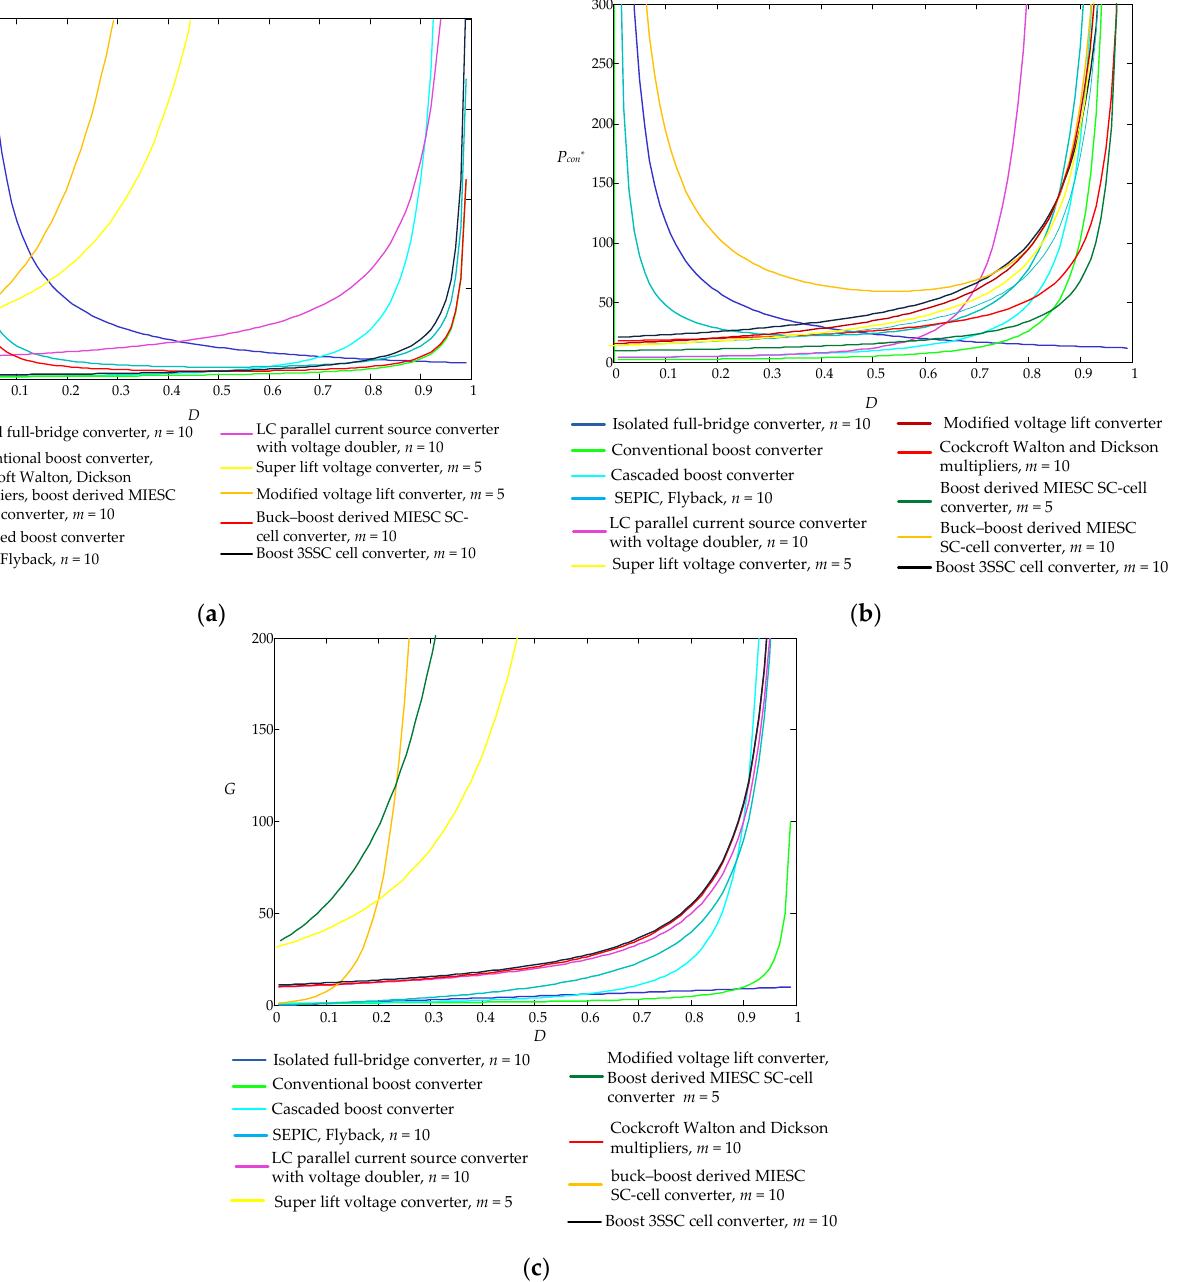
Figure 19. In high voltage gain converters: ( a ) cost factor k C ; ( b ) normalized power loss P con * ; and ( c ) voltage gain G.